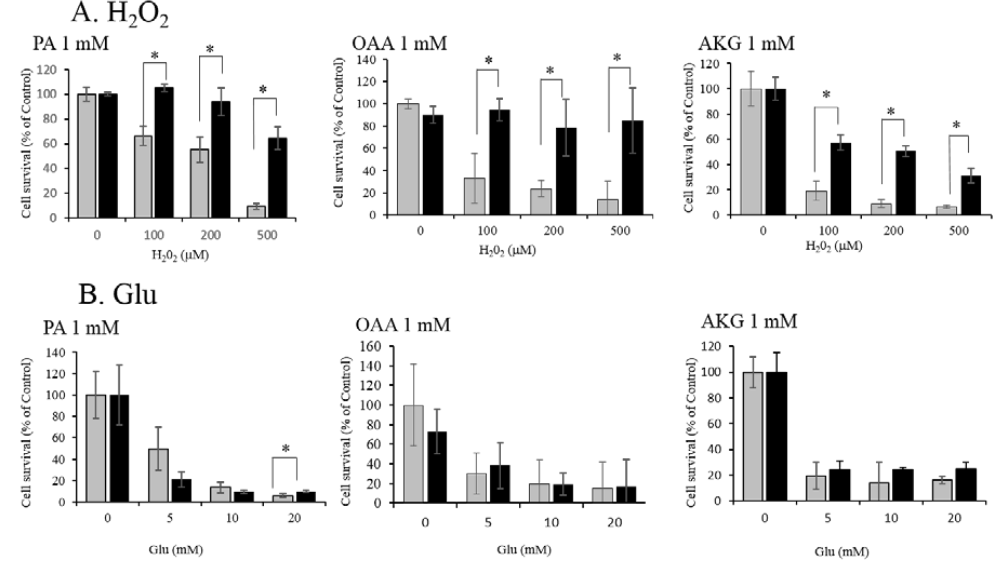
Figure 1. Protection of HT22 against ( A ) H 2 O 2 and ( B ) Glu by pyruvate (PA), oxaloacetate (OAA), and α-ketoglutarate (AKG). ( A ) Protective effects of 1mM PA, OAA, or AKG against various concentrations of H 2 O 2 . ( B ) No protective effect of 1 mM PA, OAA, or AKG against high concentrations of Glu was found. White bars indicate H 2 O 2 or Glu alone; and gray bars H 2 O 2 + KCI (PA, OAA, or AKG). Values, presented as a percentage of the control MTT (3-(4,5-dimethylthiazol-2-yl)-2,5-diphenyl tetrazolium bromide) value (obtained in the absence of glutamate), are given as the mean ± SD ( n = 4). * significantly different ( p < 0.05) from samples without a KCI. KCI: Krebs cycle intermediate.